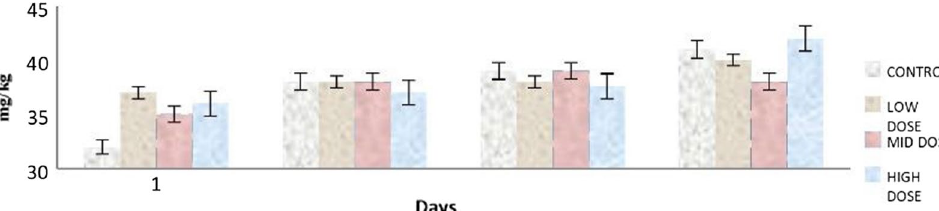
10 values are mean S.D = ±